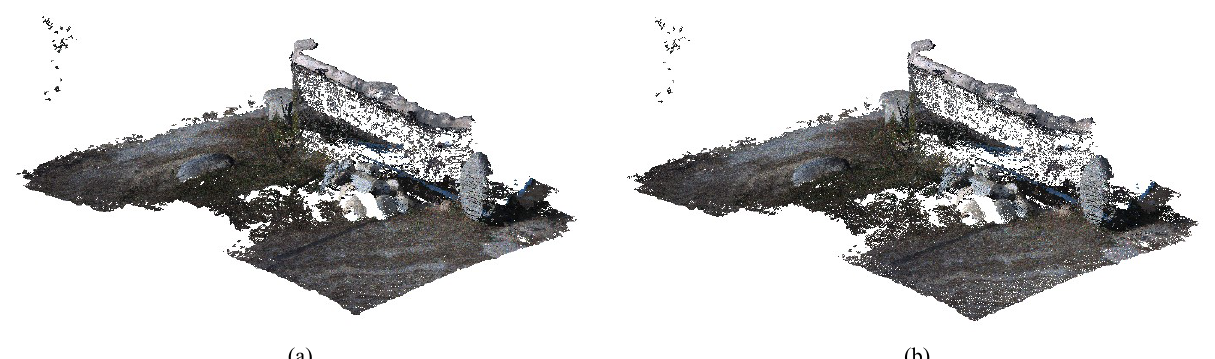
Figure 2. (a) Integrated point cloud, (b) Integrated point cloud with voxel grid